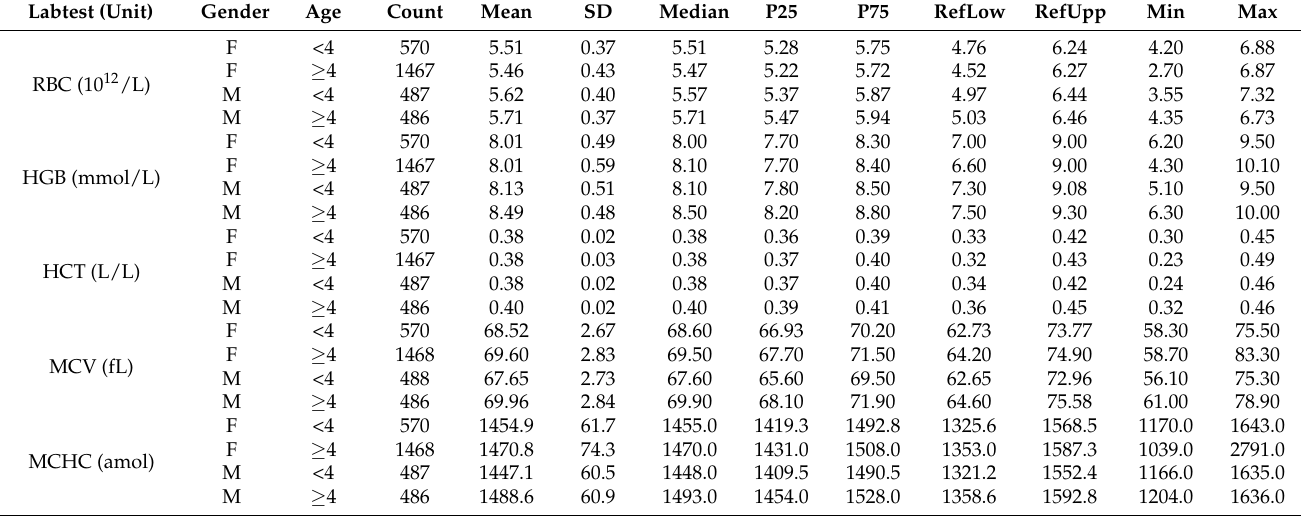
Table 4. Hematologic reference intervals and percentiles in the rhesus